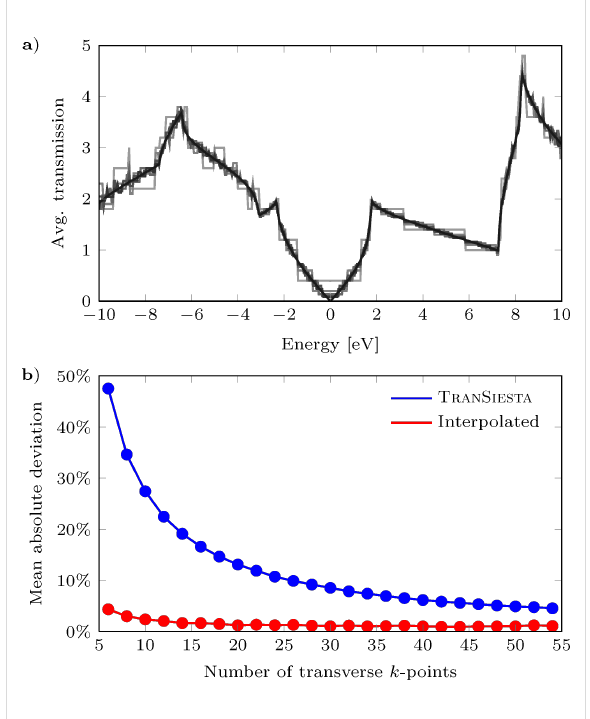
Figure 1: Analysis of transmission in pristine graphene: (a) Transmis- sion converges as the number of transverse k -points increases (darker colors). (b) The mean absolute deviation from fully converged data shown for TranSiesta data before and after using our